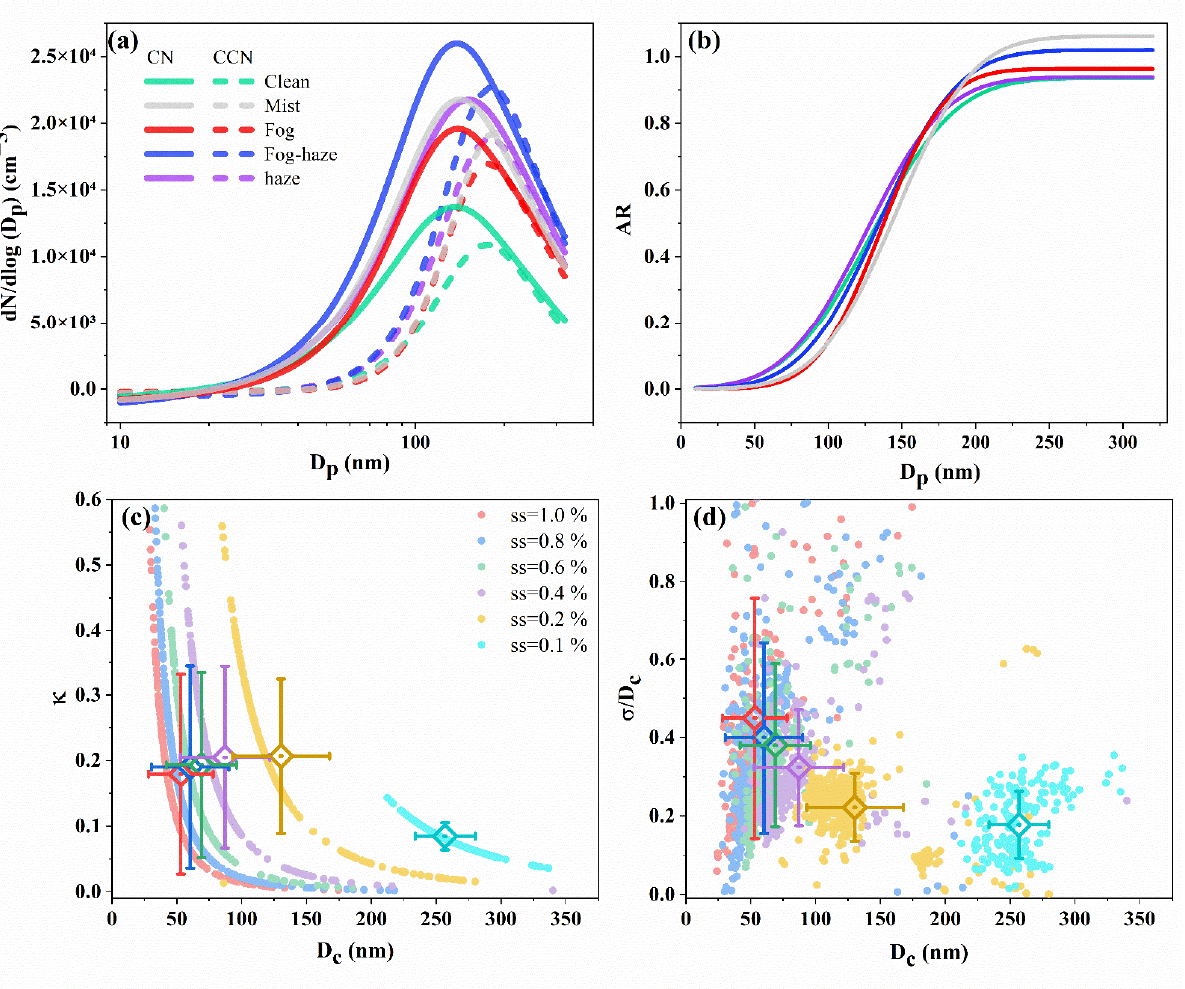
Figure 4. The averaged ( a ) size distributions of condensation nuclei (CN) and cloud condensation nuclei (CCN) and ( b ) size ‐ resolved particle activation ratio. ( c ) Particle critical activation diameter ( D c ) vs. aerosol hygroscopic growth parameters ( κ ) and ( d ) heterogeneous parameters ( σ / D c ) derived from CCN activation curves at different supersaturation (SS). The error bar represents the standard deviation of parameters at different SS.